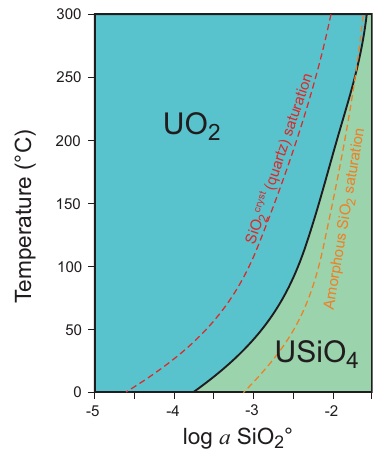
Fig. 4 Phase stability diagram for UO 2 and USiO 4 . Stability fi elds of UO 2 and USiO 4 plotted as a function of temperature and activity of dissolved silica in co-existing solutions. Dashed lines on the diagram represent calculated saturation levels with respect to crystalline (red) and amorphous (orange) SiO 2 (reproduced from ref. 25